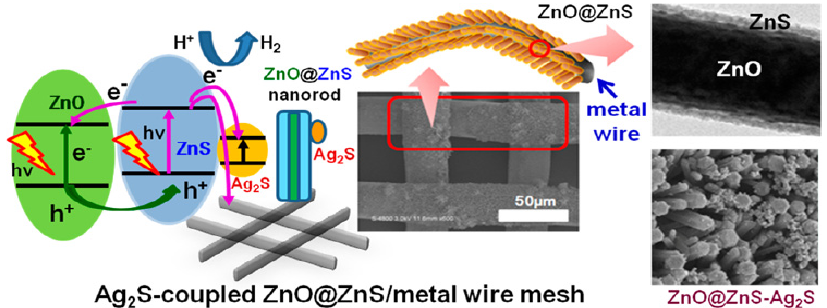
Figure 10. Schematic mechanism of hydrogen evolution on Ag 2 S-ZnO@ZnS/mesh photocatalyst. Copyrights 2016 ACS [121].